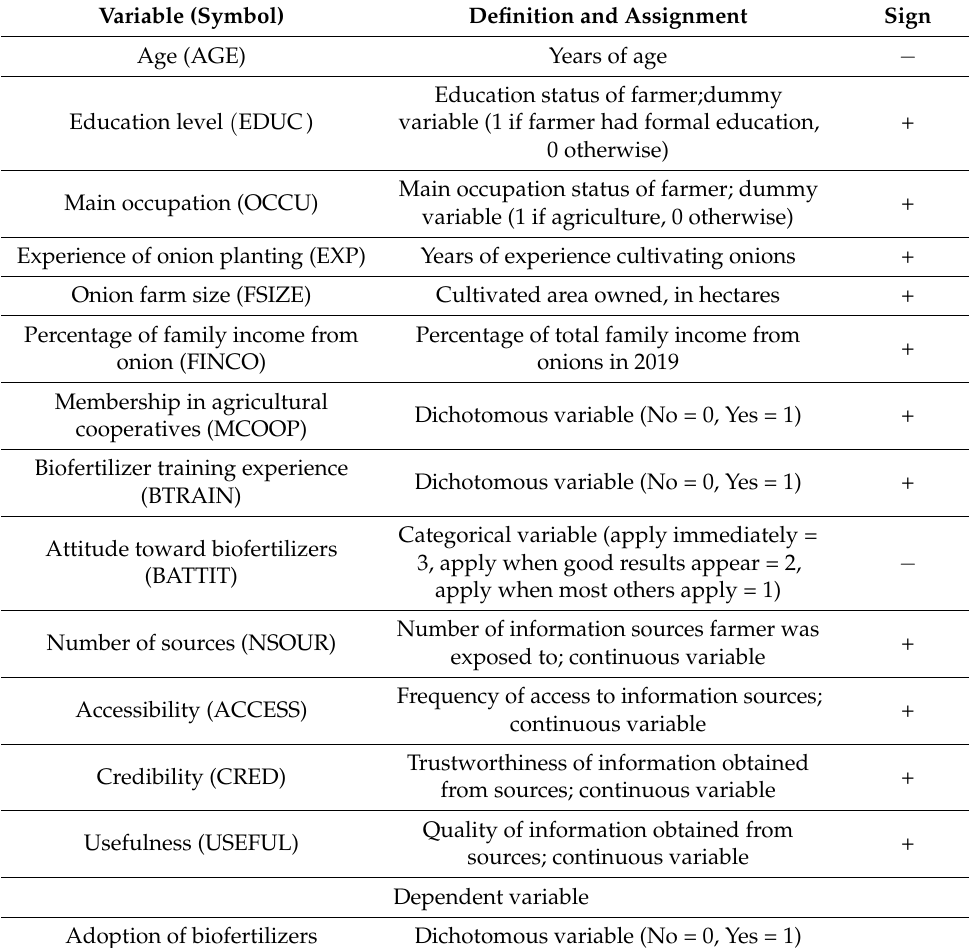
Table 1. Variable settings and descriptions in adoption